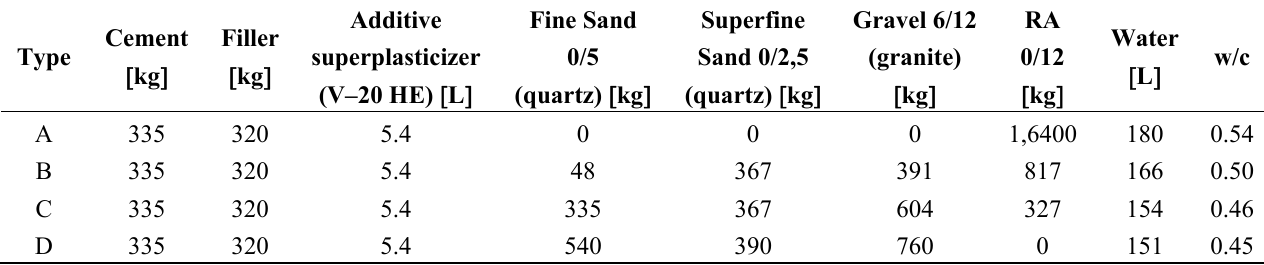
Table 2. Recycled self-compacting concrete RSCC-50